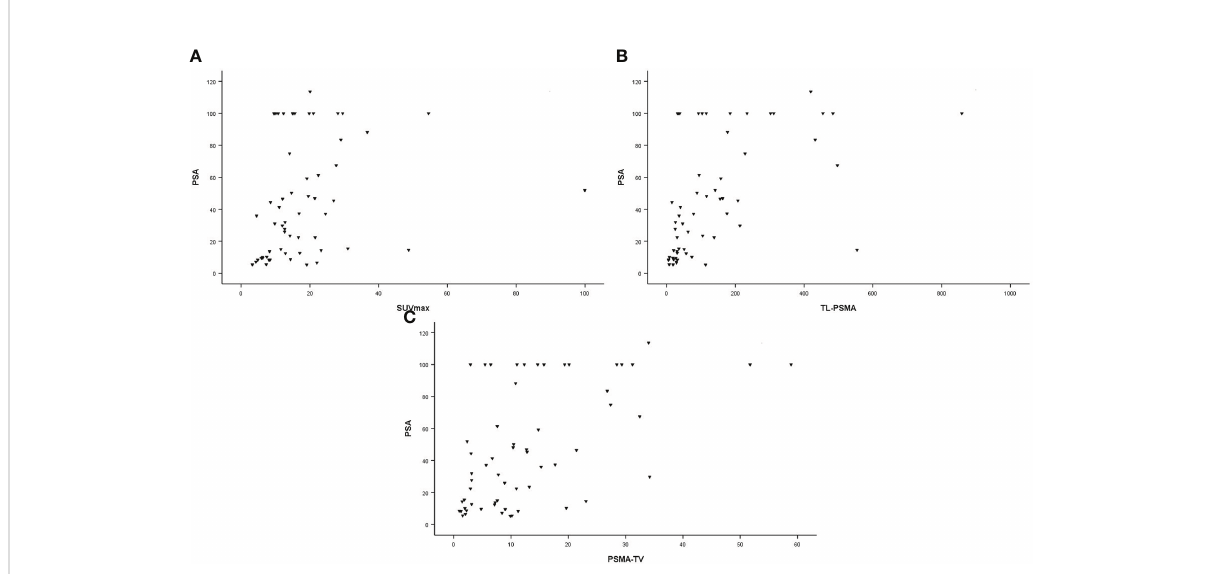
FIGURE 2 Correlation between PSA values (ng/ml) and primary tumor prostate-speci fi c membrane antigen (PSMA) PET parameters. (A) Maximum standardized uptake value (SUVmax; r = 0.411; p = 0.001). (B) Prostate total lesion PSMA (TL-PSMAp [cm 3 ]; r = 0.663; p < 0.001). (C) prostate PSMA-tumor volume (PSMA-TVp [cm 3 ]; r = 0.549; p <